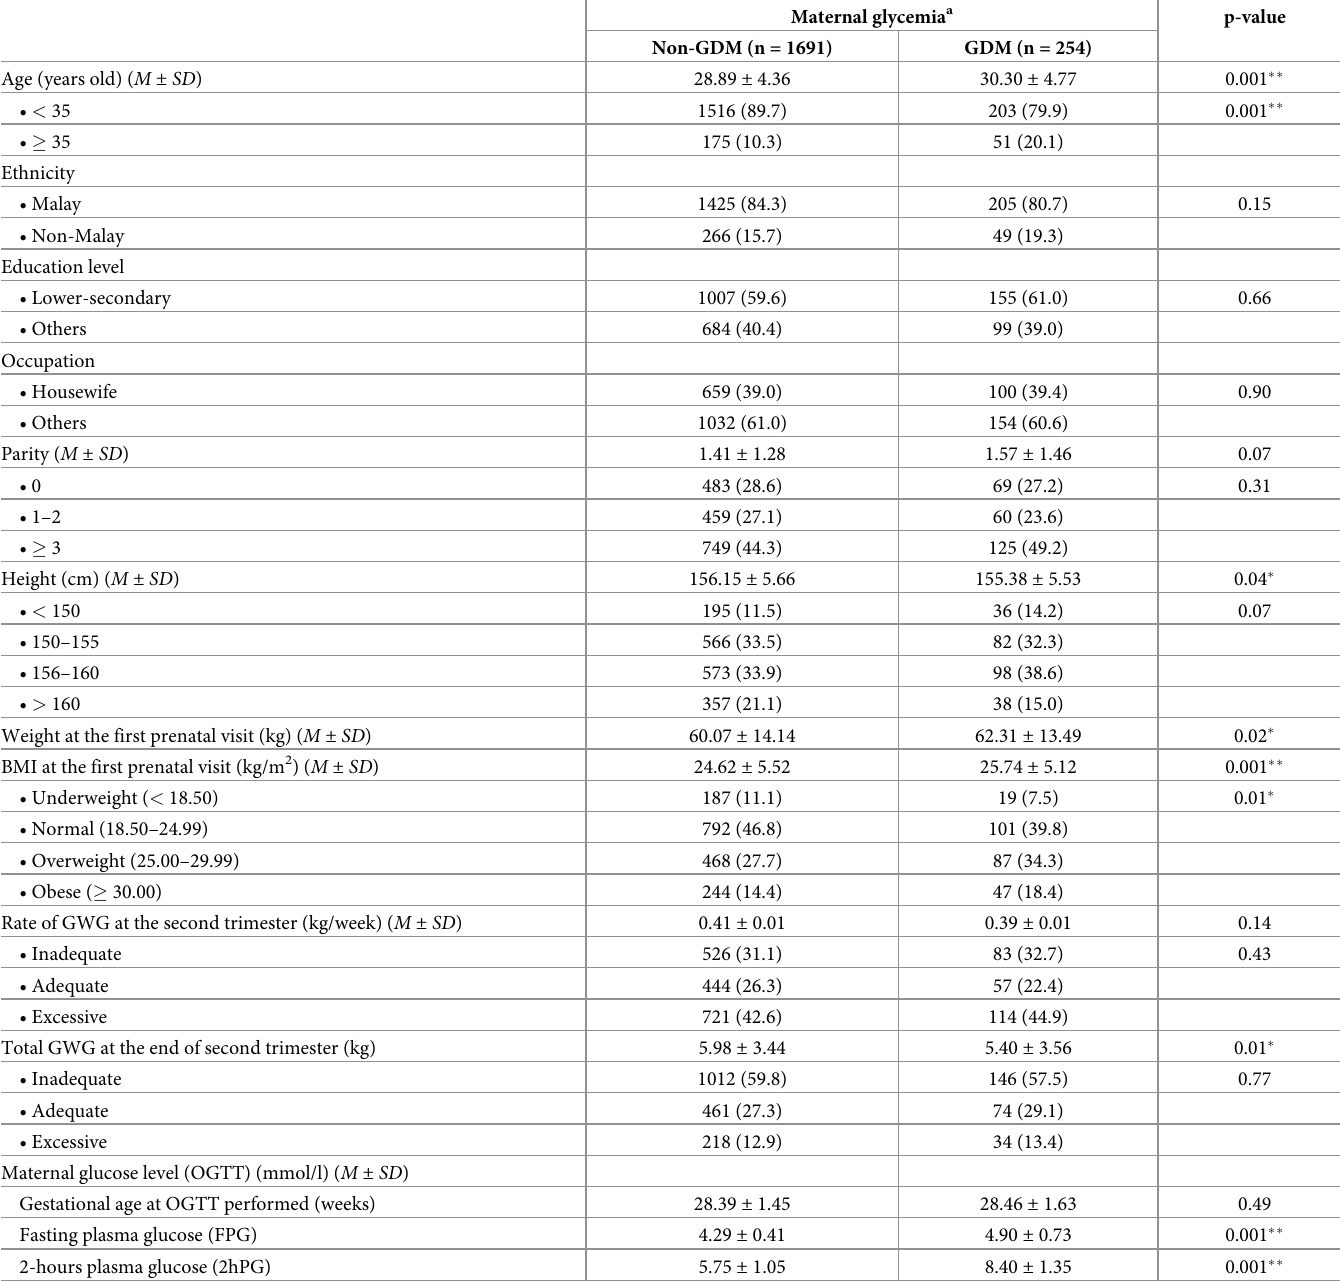
Table 1. Characteristics of women with GDM and non-GDM (N =